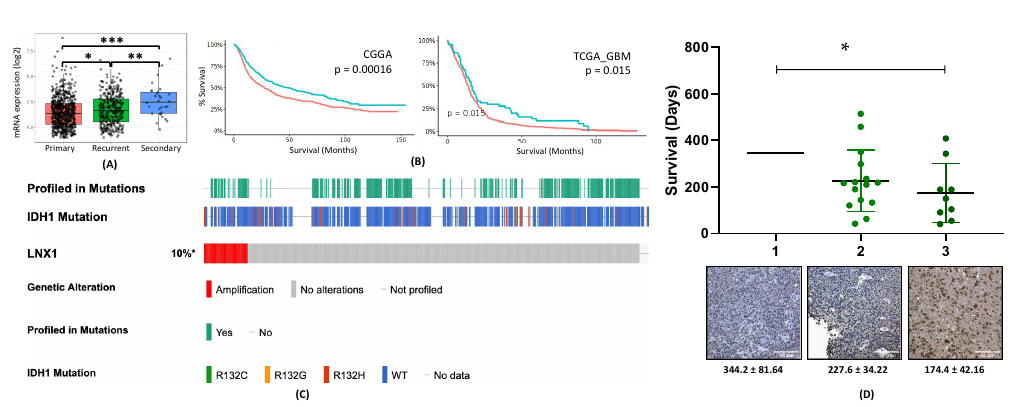
Figure 2. LNX1 is elevated in Glioblastoma (GBM) patients and correlates with patient outcomes. ( A ) LNX1 expression was approximated in the Chinese Glioma Gene Atlas (CGGA) dataset and was shown to elevate significantly with each recurrence ( B ) In two datasets, using optimal cuto ff analyses, elevated LNX1 expression was shown to be correlated with significantly worsened survivals for patients. ( C ) LNX1 expression was tabulated across over 500 patient samples, based on the Cancer Genome Atlas (TCGA) data, and showed amplification in 10% of samples, with no correlation to the IDH status of the patient. ( D ) LNX1 expression was scored in patient samples by a certified neuropathologist and scores were plotted against survival, with a significant di ff erence in survival between high and low LNX1 expression. Significance was calculated in Prism 8 using Student’s t-test for 2 samples or ANOVA for greater than 2 samples. Tukey’s Honest Significance Di ff erence was applied to determine significance for TCGA expression data and log-rank testing was used to compare survival